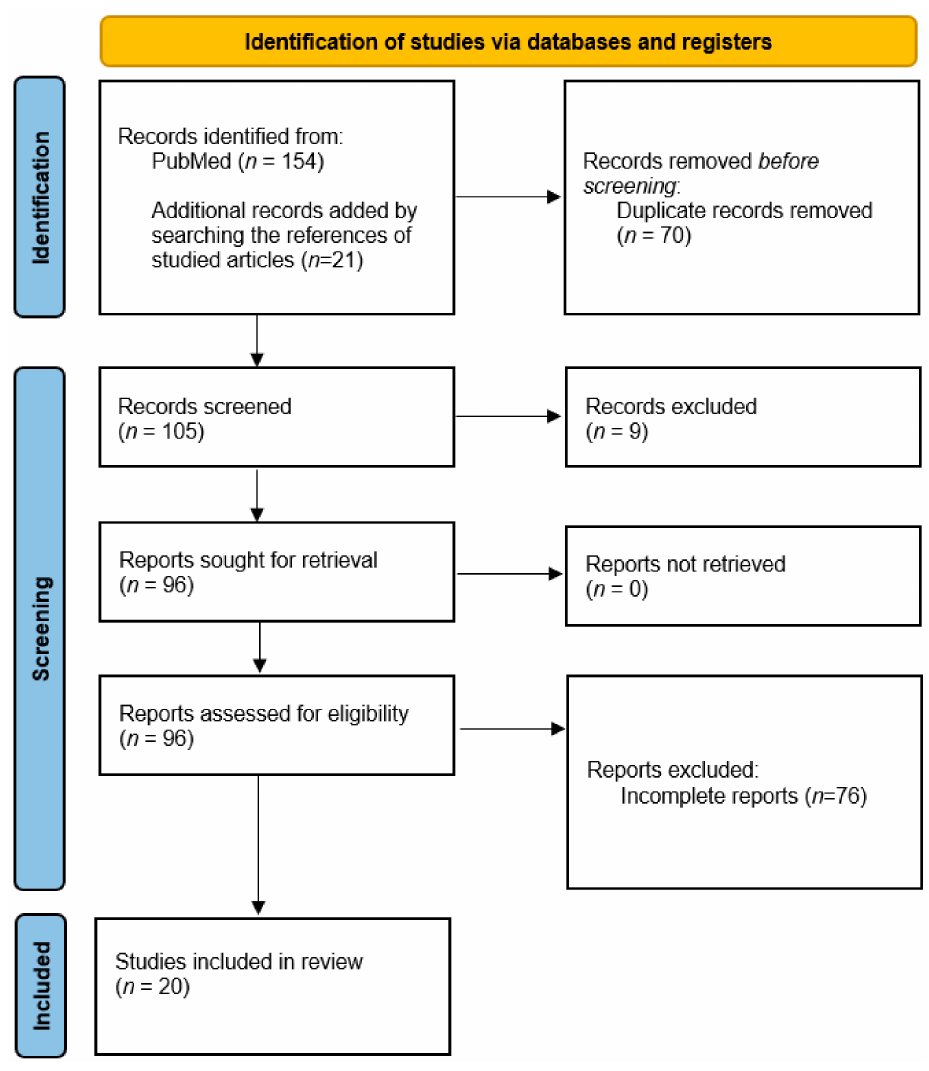
Figure 1. PRISMA flow diagram for the systematic